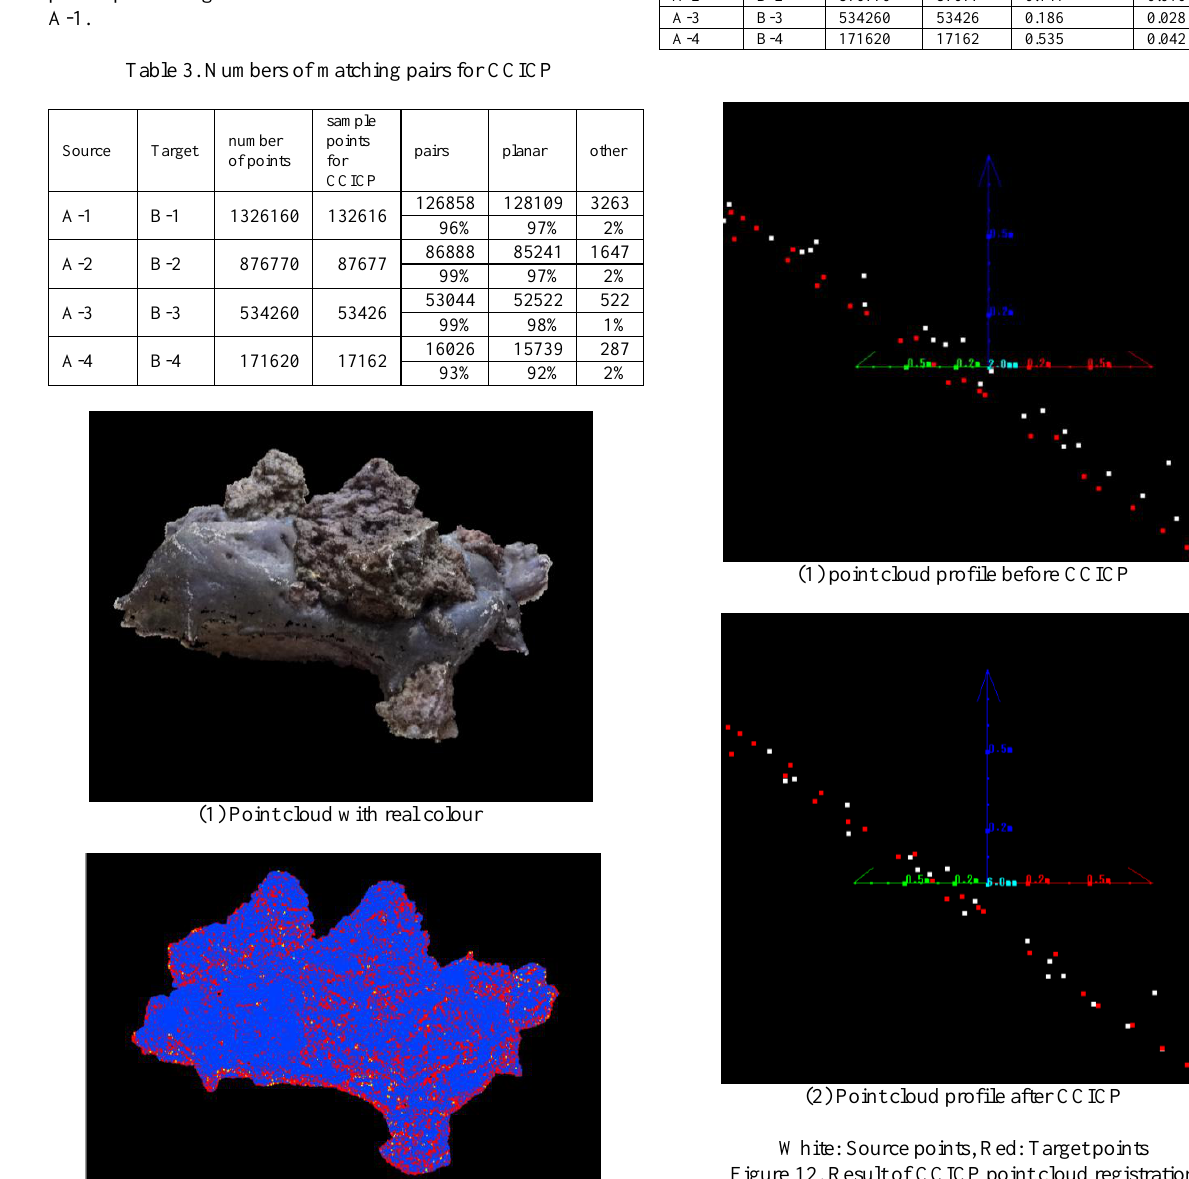
Figure 12. Result of CCICP point cloud registration